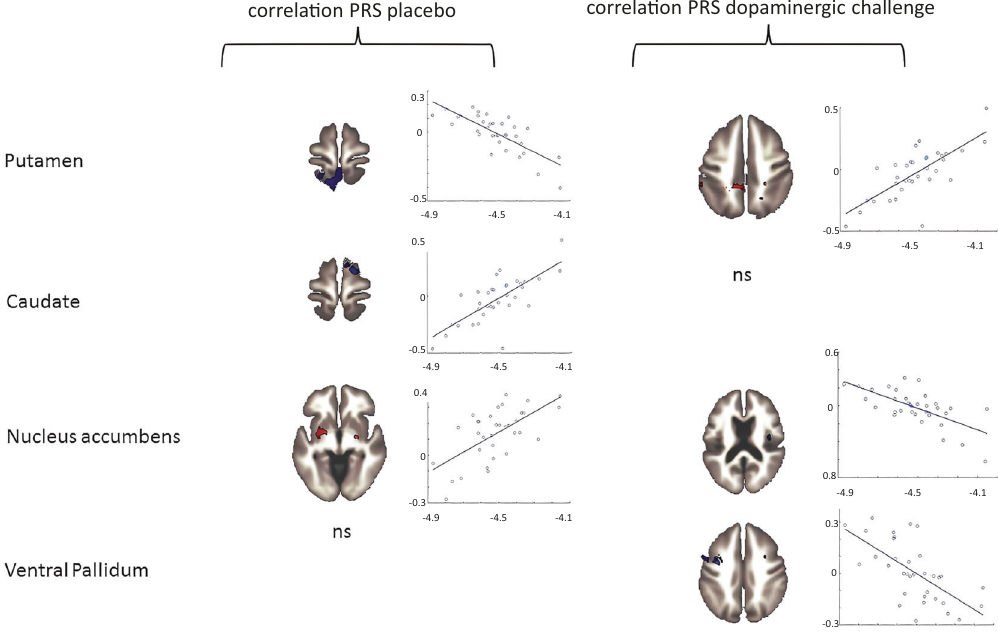
Fig. 2 Relation between genetic risk, functional connectivity, and dopaminergic challenge. The left column gives the name of the seed region-of-interest. The column titled “ correlation PRS placebo ” shows an exemplary slice of a brain with a signi fi cant cluster, the scatterplot gives the direction of the effect. The column on the right “ correlation PRS dopaminergic challenge ” gives the same, slice with signi fi cant cluster and scatterplot, for the intrasubject difference L-DOPA > placebo in dependence of the polygenic risk. The scatterplots show the functional connectivity gives as correlation and the difference between L-DOPA and placebo on the y axis and the polygenic risk on the x axis. PRS polygenic risk, ns not signi fi cant.